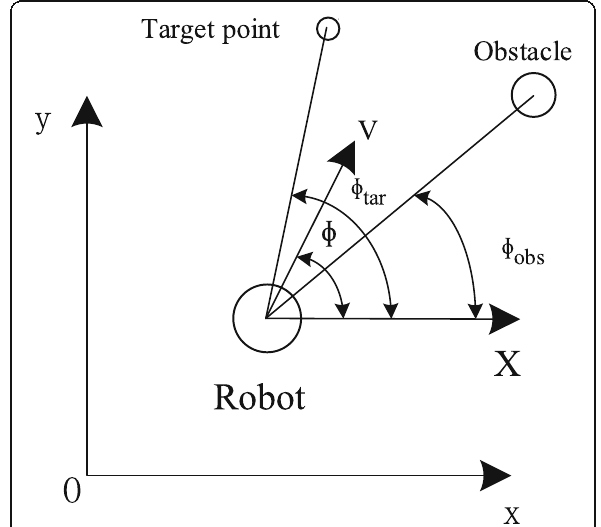
Fig. 1 Robot model. The coordinate system OXY is the world coordinate system, the robot coordinate system takes the robot position as the origin, the X -axis is parallel to the X -axis of the world coordinate system, and the Y -axis is perpendicular to the X -axis (not